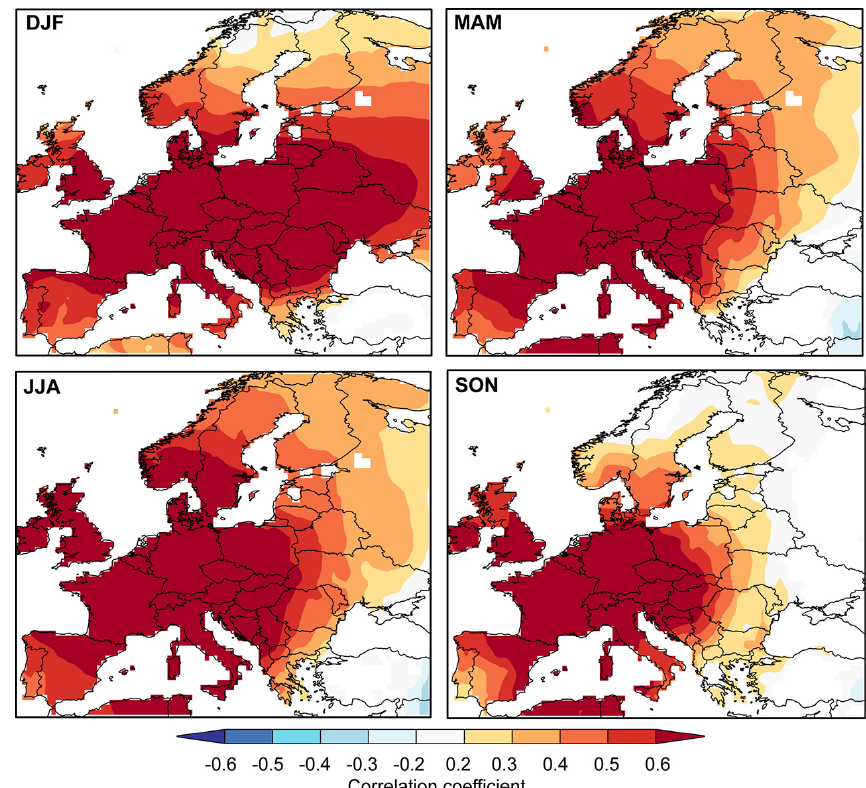
Figure 13. Spatial correlations between reconstructed seasonal central European temperature series by Dobrovolný et al. (2010) and gridded European temperature reconstructions by Luterbacher et al. (2004) and Xoplaki et al. (2005) in the 1501–2002CE period.